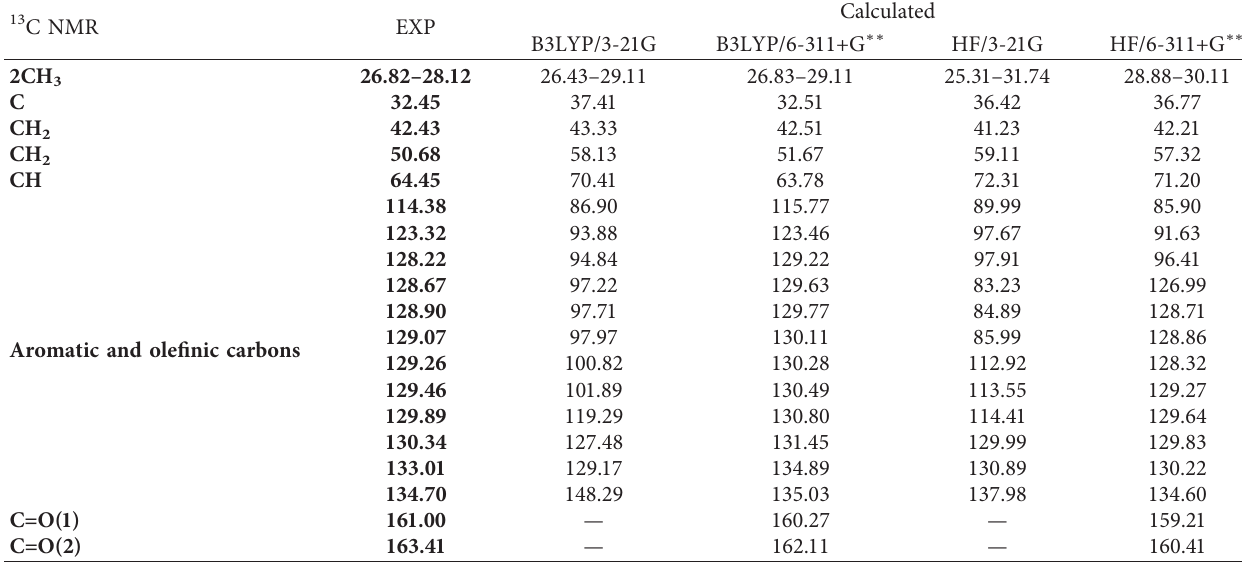
Table 8: Experimentally measured and calculated 13 C chemical shifts δ (ppm vs TMS) of the compound (5b) . 13 C